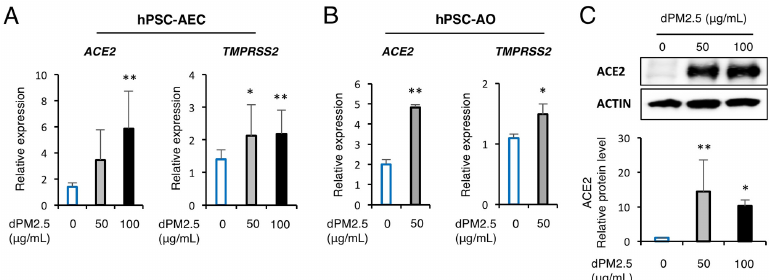
CPM, and HOPX, red), AEC1 (AQP5 and T1 α , green), AEC2 (SFTPC, red) and mesenchymal stromal 4 (cid:48) ,6-diamidino-2-phenylindole (DAPI) (blue). Scale bars, 100 µ m. ( D ) qPCR analysis of the indicated AEP and AEC markers in AOs. Data are shown as fold-change relative to undi ff erentiated hPSCs (unhPSC). Data is presented as mean ± SD. * p < 0.05, ** p < 0.01. ( E ) Schematic diagram of dPM2.5 treatment during hPSC-derived AO development. Black lines indicate the duration of dPM2.5 treatment. Scale bars, 100 µ m. ( F ) Measurement of AO size was taken by averaging the longest and shortest diameter of AOs. ( G , H ) Transcript levels of inflammation, fibrosis, and EMT-related genes